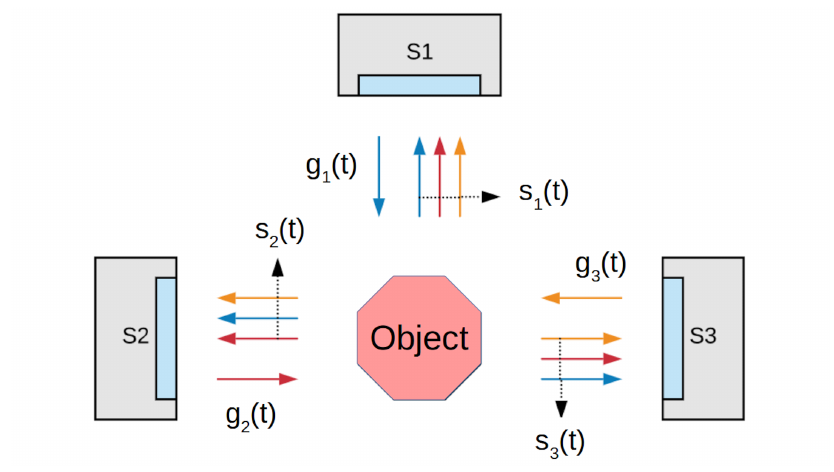
Figure 2. ToF camera phase-measurement principle